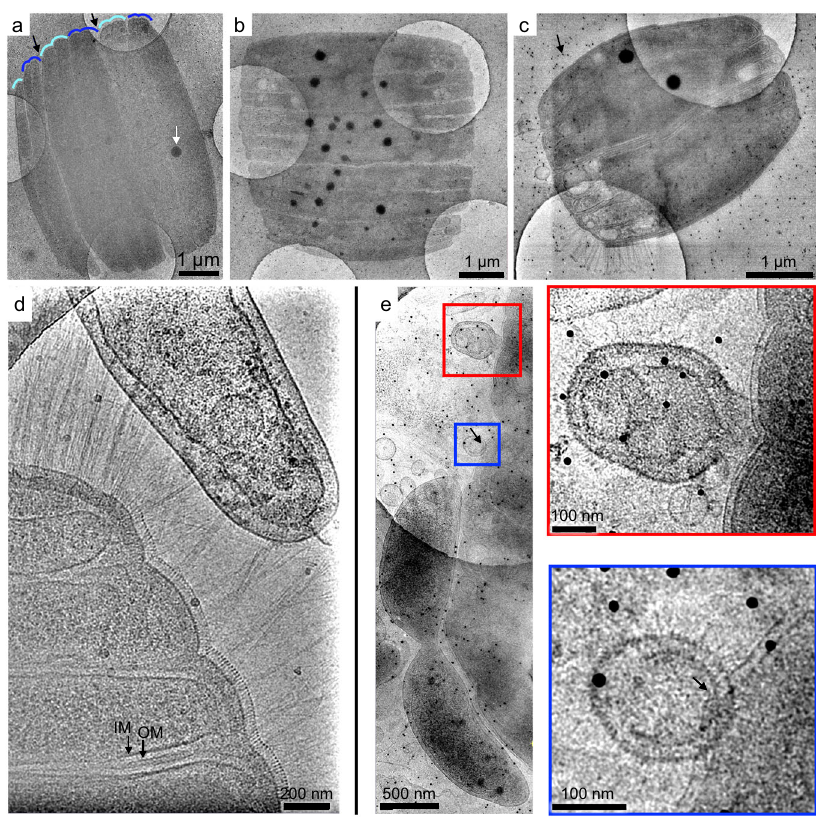
Fig. 5 | CryoTEM demonstrates that RBSs consist of multiple parallel, likely paired segmentsand are oftennear other cells. Band-pass fi ltered and denoised low-magni fi cation a , b images or c montage cryoTEM images of RBSs on an R2/2 holey carbon TEM grid. Higher-magni fi cation images showing d pilus-like appen- dagesand e proximalcellsandinteractingvesiclesattheRBSperiphery.In( a ),pairs ofsegmentsarehighlightedwithalternatingshadesofblue,andsharpindentations between groups of segments are denoted with black arrows. Dense spheroidal